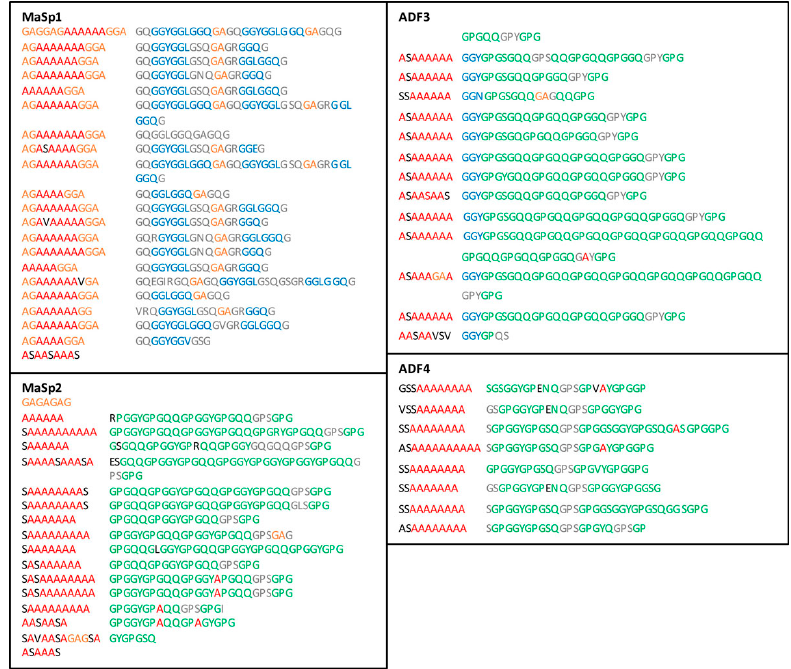
Figure 7. Amino acid sequences for the spidroins composing the MA gland silk of Araneus diadematus (ADF3 and ADF4) [23] and Nephila clavipes (MaSp1 and MaSp2) [21,22]. Single letter code for amino acids is used to simplify the analysis. The A n , GA, GGX, and GPGXX motifs are inspired from those of Gatesy et al. [44] and are indicated in red, orange, blue, and green respectively, where X represents a small subset of amino acids ( X = L, Q, T, S, etc.). Amino acids that have undergone substitution in the motifs are colored in black and those that do not contribute to any motifs are colored in grey.